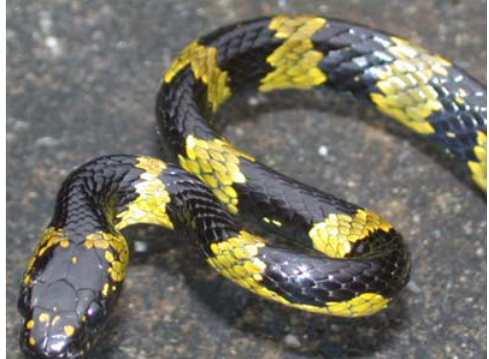
Image 2. Dorsal view of head of Dinodon gammiei from Chungthang, northern Sikkim.